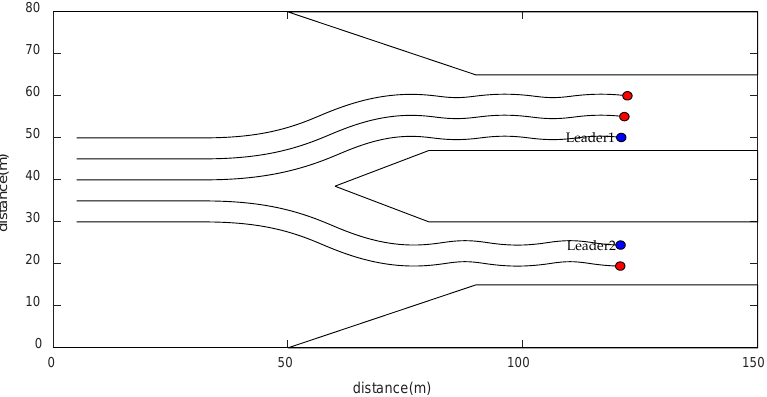
Figure 26. Trajectory of the UGVs fleet in the case of road obstruction ahead.